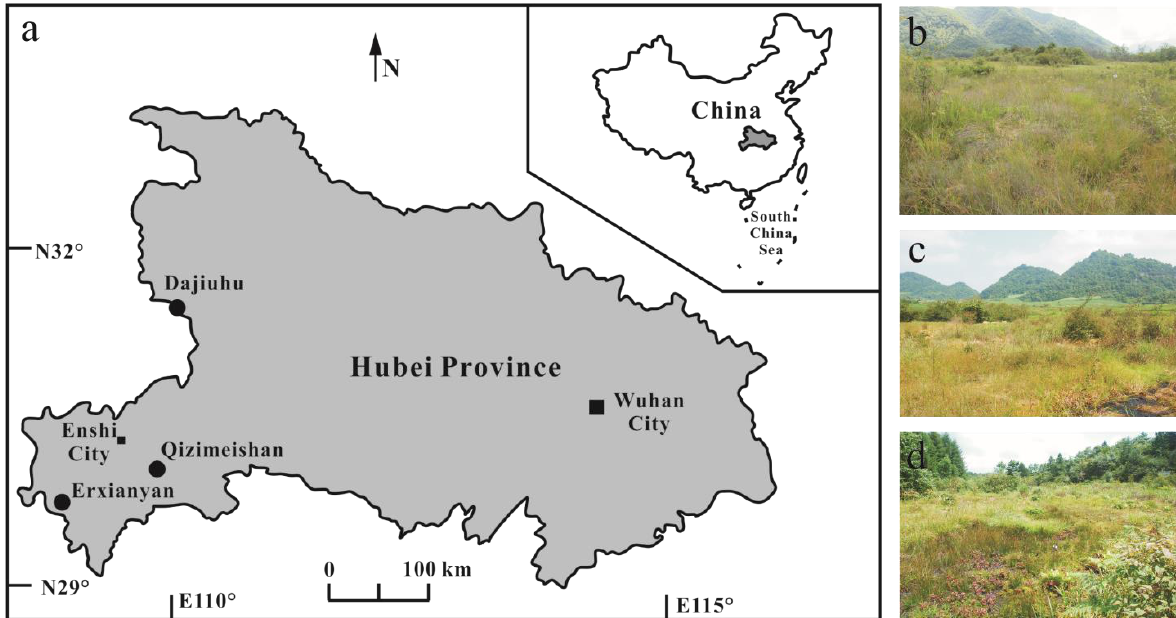
Figure 1. Locations of the three sampling sites in the study area (a) and landscape views of the Dajiuhu (b), Erxianyan (c) and Qizimeishan (d) peatlands.